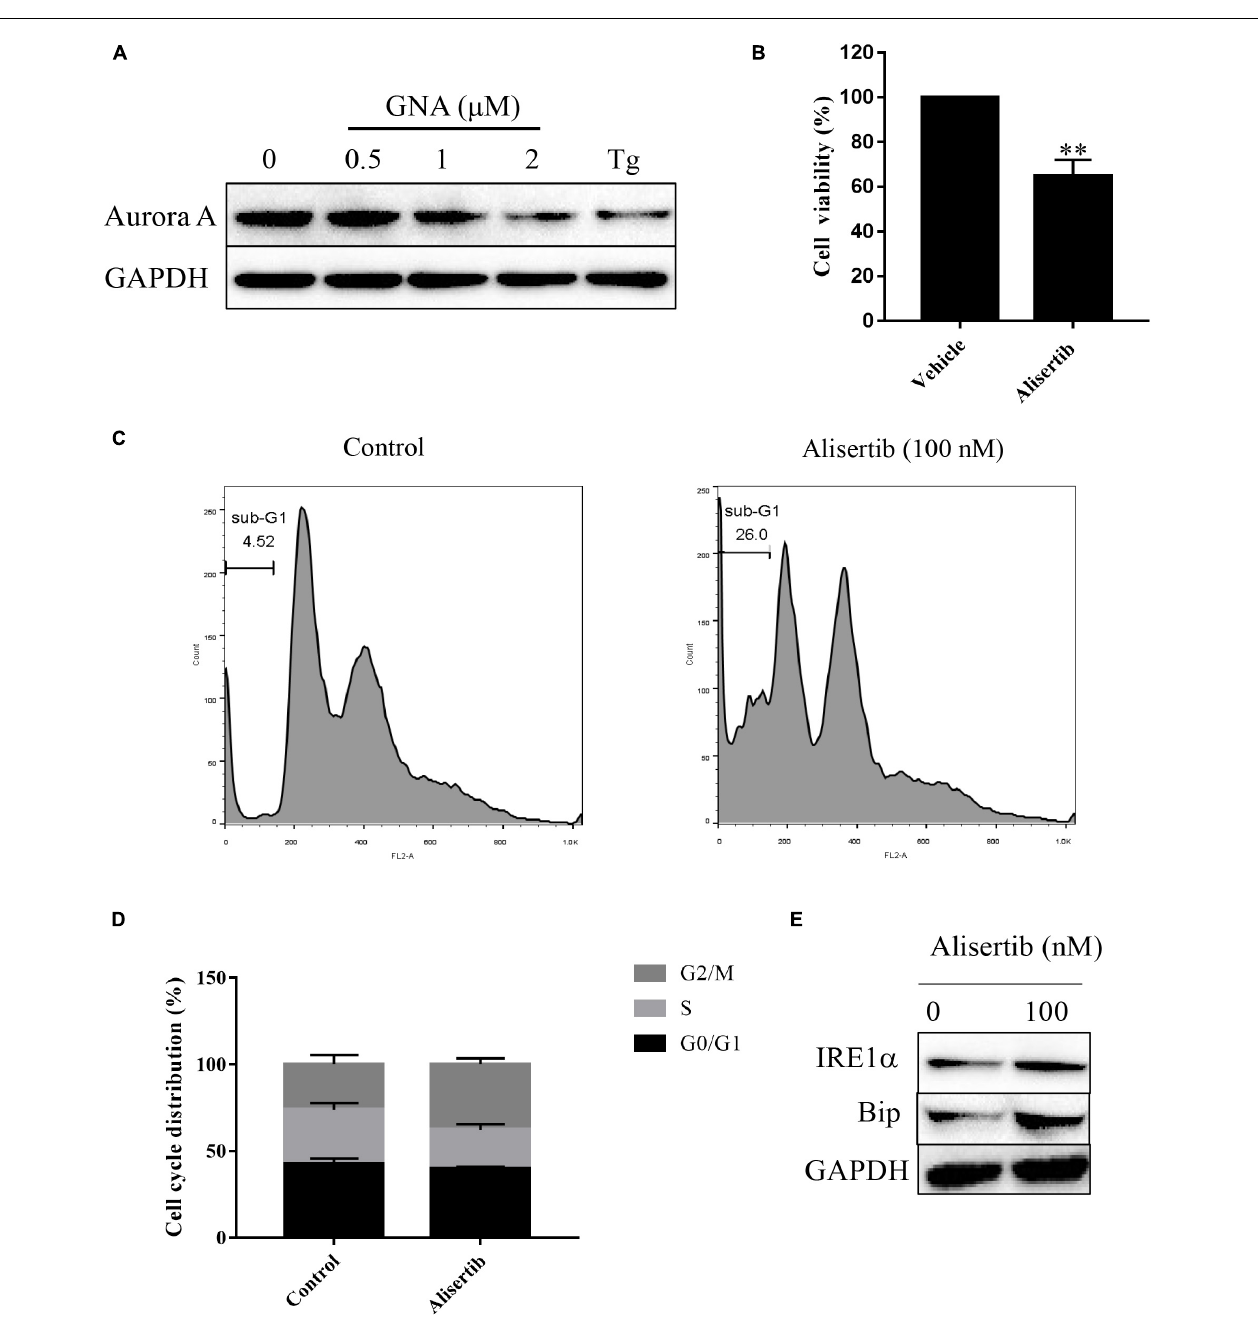
FIGURE 5 | GNA activated ER stress-associated apoptosis through Aurora A. (A) HCT116 cells were treated with different concentrations of GNA (0.5, 1, 2 µ M) and thapsigargin (1 µ M) for 6 h. The expression of Aurora A was analysed by western blot. (B) HCT116 cells treated with alisertib (100 nM) for 24 h. MTT assay was performed to detect the suppressed proliferation effect of alisertib. (C,D) HCT116 cells treated with alisertib (100 nM) for 24 h. Cells were fixed in 70% ethanol at 4 ◦ C, and the cell cycle was examined by flow cytometry after PI staining. (E) The expression of Bip and IRE1 α was analysed by western blotting. The data are presented for at least three independent experiments. The data are presented as the mean ± SD. ** P < 0.01.